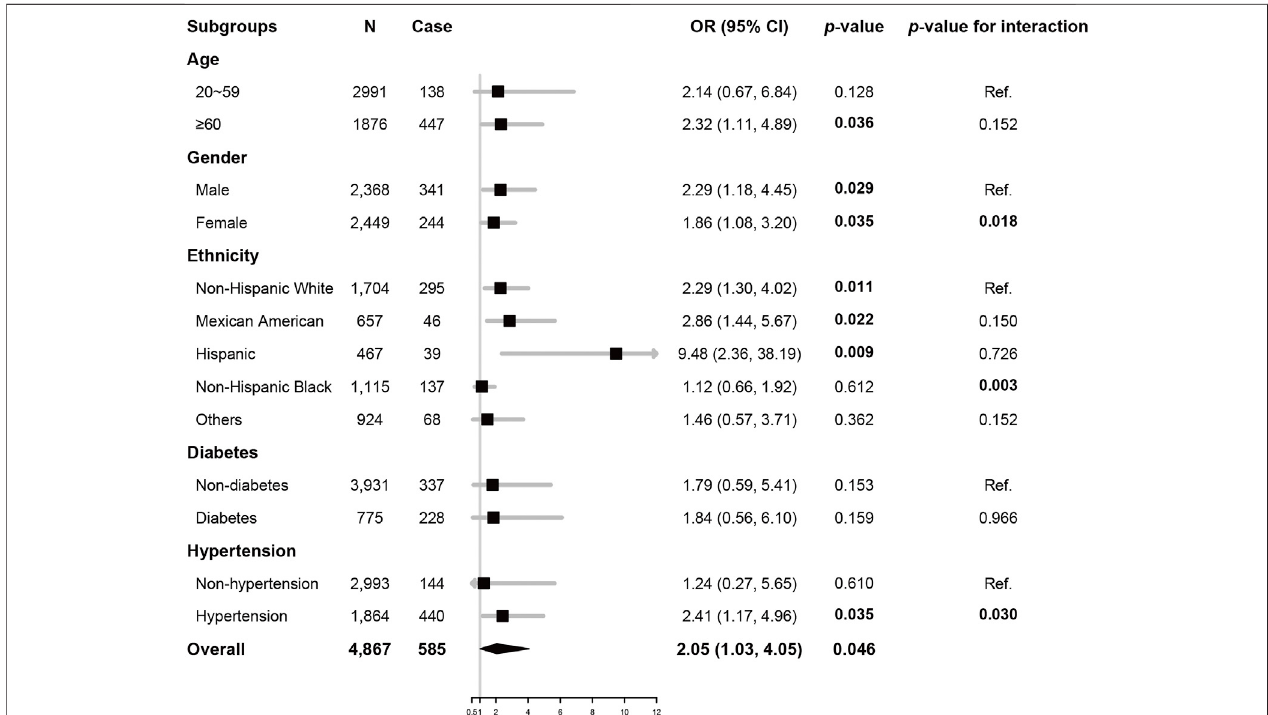
FIGURE 2 | Subgroup analysis Odds ratio of sTfR (per 1 log 2 mg/L) for total CVDs, adjusted for age, gender, ethnicity, smoking, BMI, SBP, HbA1c, and LDL-C. There were 161 and 10 participants with missing data of diabetes and hypertension, respectively, and data of these participants was excluded from subgroup analysis accordingly. Abbreviations: OR, odds ratio; CI, con fi dence interval; sTfR, soluble transferrin receptor; BMI, body massindex; SBP, systolic blood pressure; LDL-C, low- density lipoprotein-cholesterol; HbA1c, glycated hemoglobulin A1c.